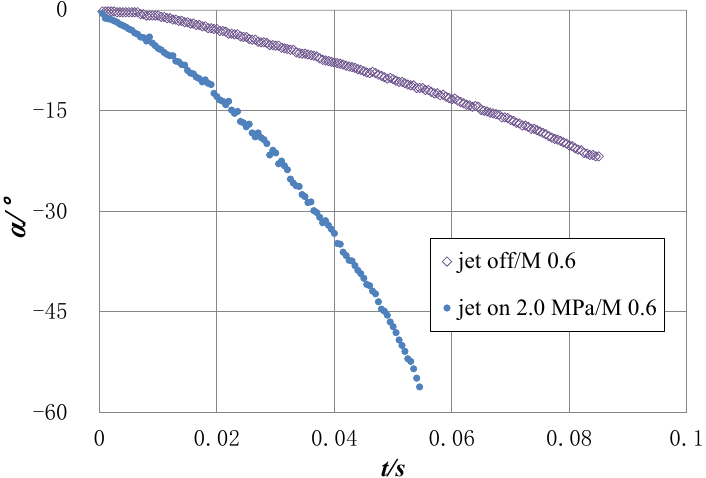
Figure 14. Angle of attack curve of revolution body at M = 0.6 with a jet at 2.0 MPa and without a jet.